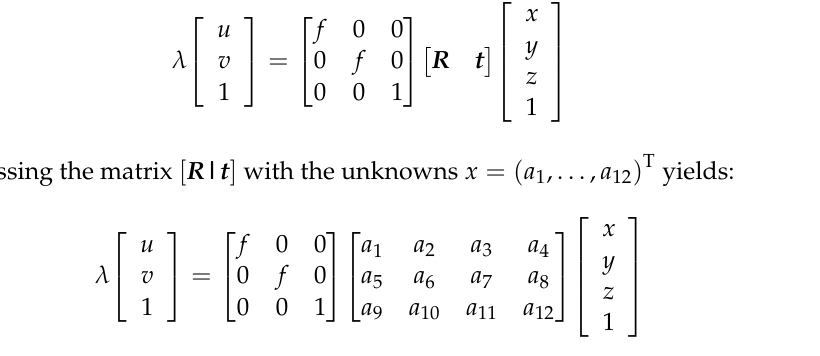
Set the internal parameter matrix K of the scanning galvanometer as: